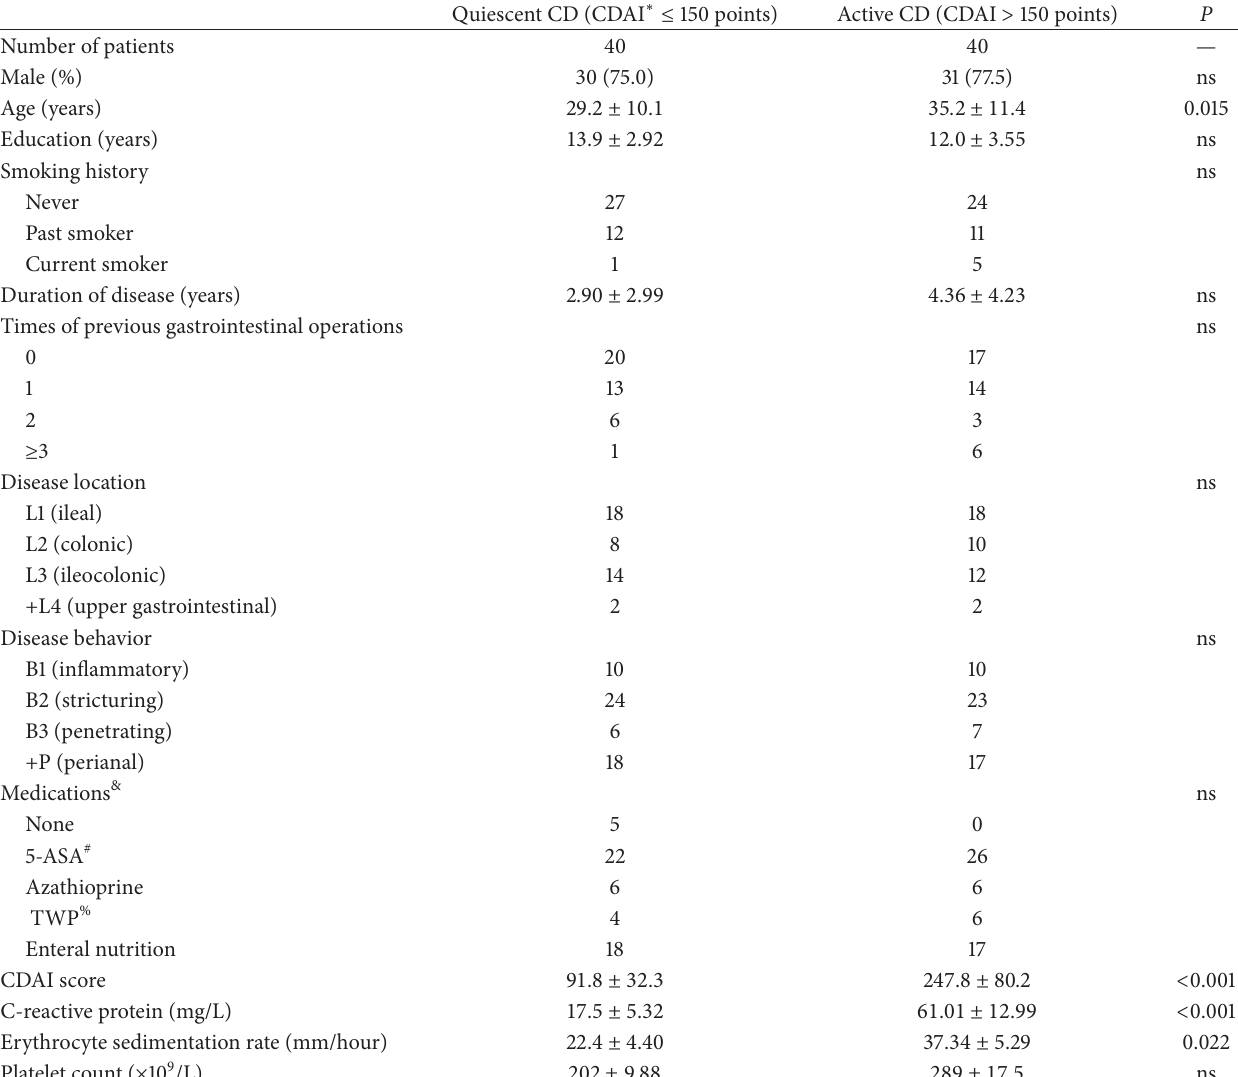
Table 2: Demographics and clinical characteristics in patients with Crohn’s